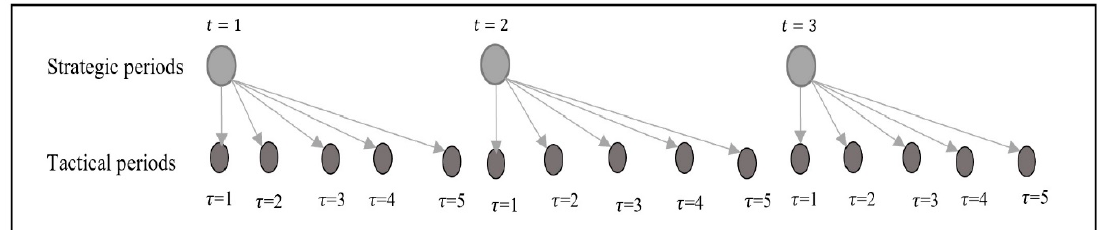
Figure 1. Strategic and tactical decision differentiation in the proposed model.